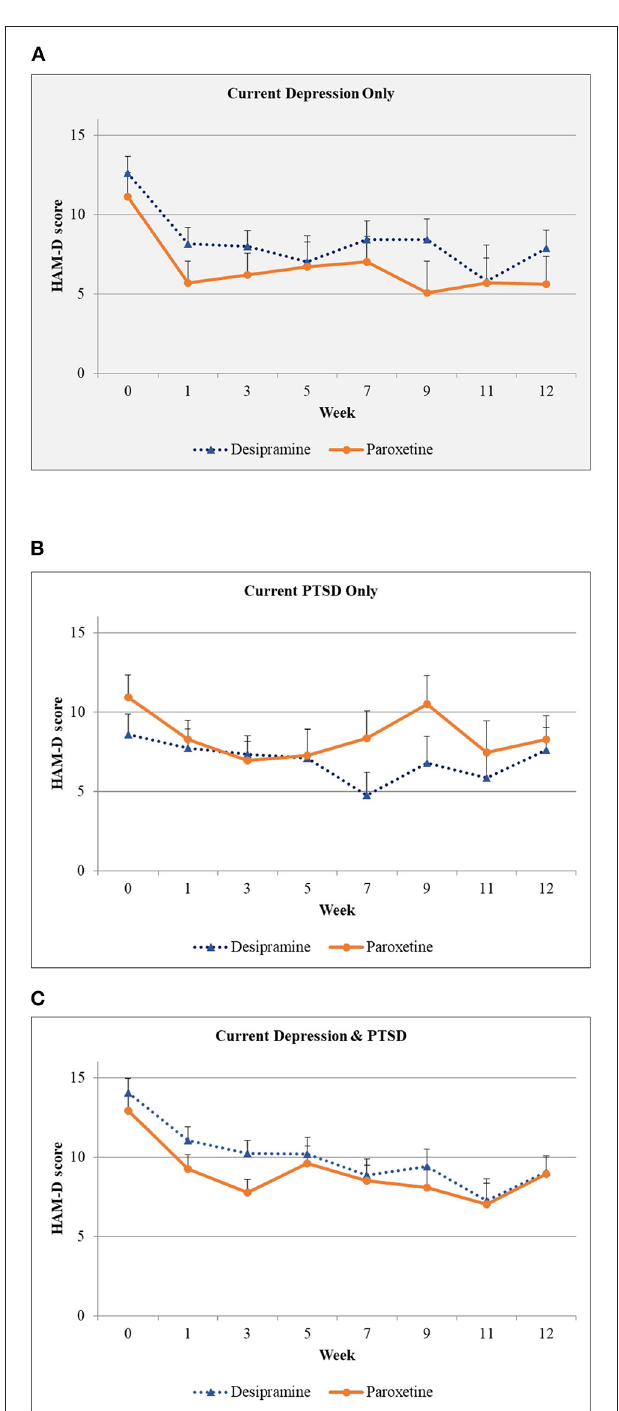
FIGURE 4 | Hamilton Depression Scale scores over time by diagnostic group. (A) Depression scores over 12 weeks of treatment for those diagnosed with depression only who were given either desipramine or paroxetine. Shaded background indicates that this group had a significantly lower depression scores on paroxetine when compared to desipramine. (B) Depression scores over 12 weeks of treatment for those diagnosed with PTSD only who were given either desipramine or paroxetine. (C) Depression scores over 12 weeks of treatment for those diagnosed with depression + PTSD who were given either desipramine or